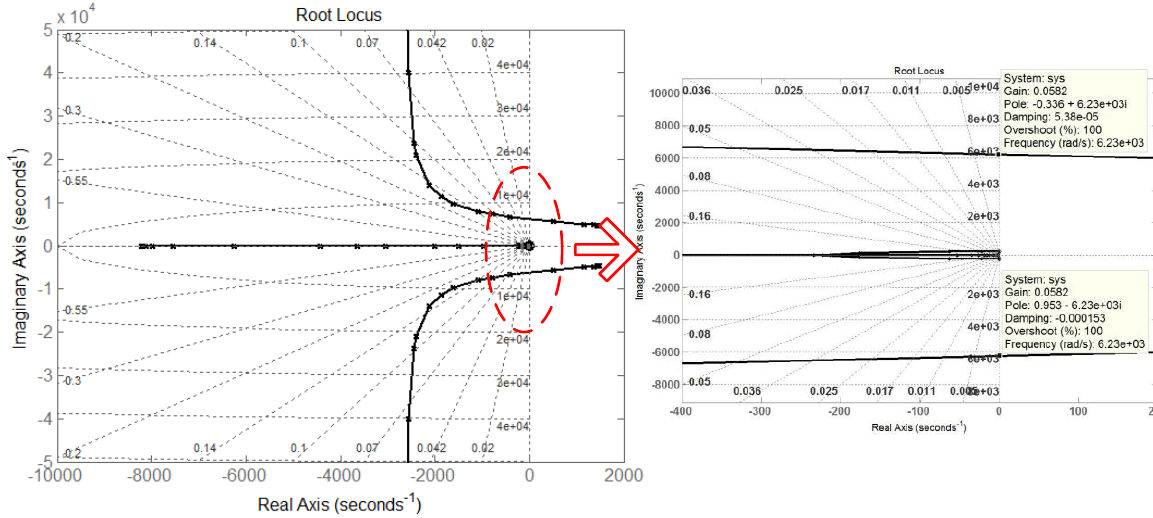
while other parameters are 𝑝